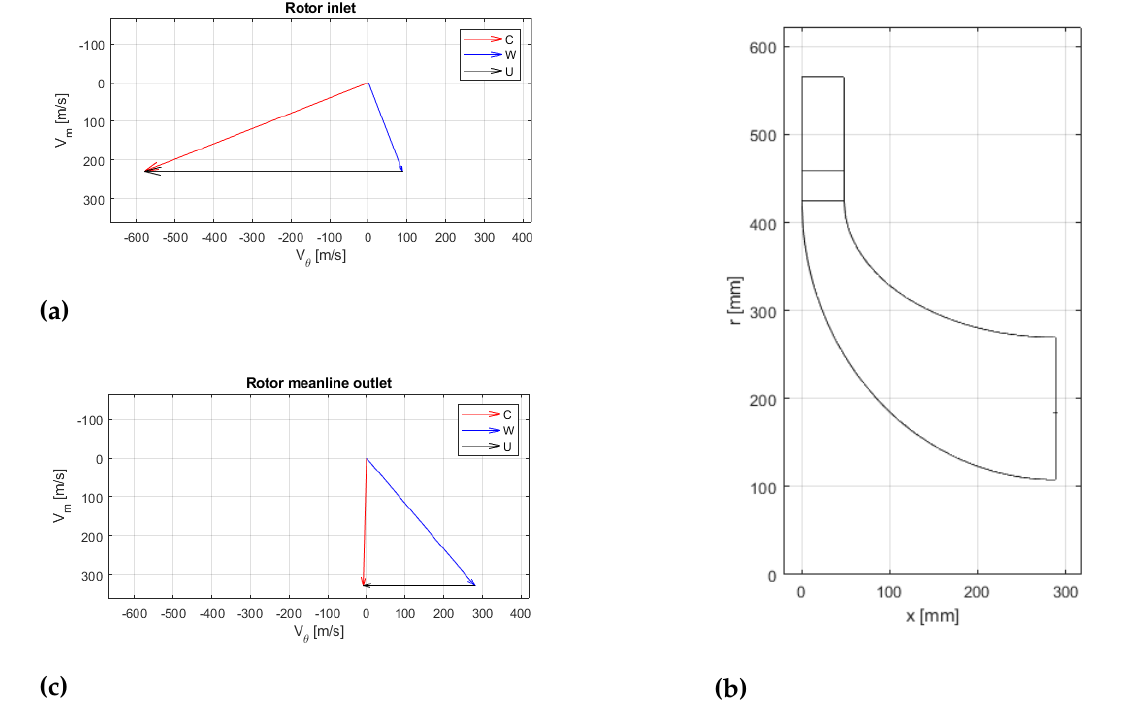
Figure 6. Turbine 1D design: (a) rotor inlet and (b) meanline rotor outlet velocity triangles, (c) meridional channel. 1: stator inlet, 2: stator outlet; 3: rotor inlet; 4: rotor outlet